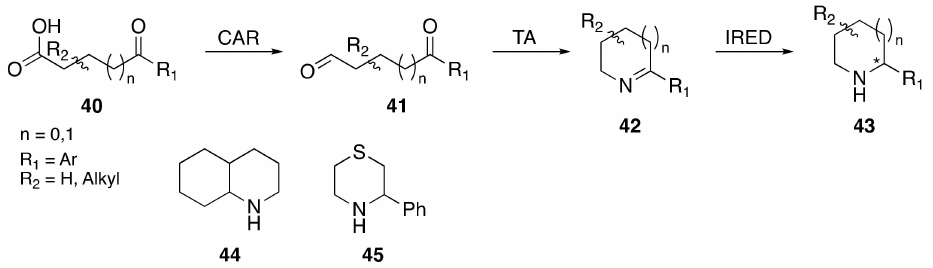
Figure 9. Three-enzyme cascade for the synthesis of saturated N